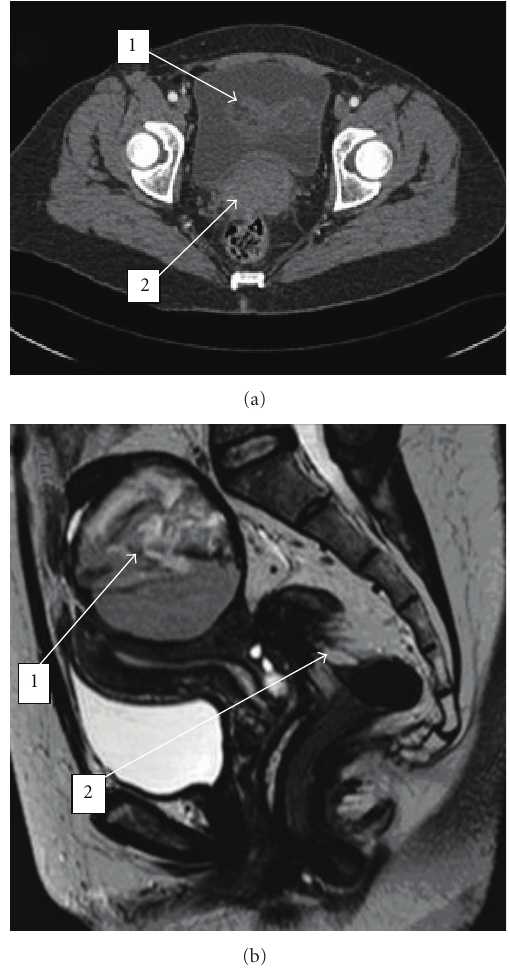
Figure 1: (a) An axial CT angiogram of the pelvis performed 3 months after delivery. (1) indicates a pelvic mass. (2) demonstrates a bulky cervix with a surrounding ill-defined outline where an underlying cervical malignancy could not be ruled out at this point. (b) T2 sagittal MRI scan taken 4 months after delivery. (1) highlights pelvic endometriosis with a left endometrioma sitting over the uterine fundus. (2) demonstrates tethering of the plaque to the ventral rectosigmoid junction indicating the severity of the